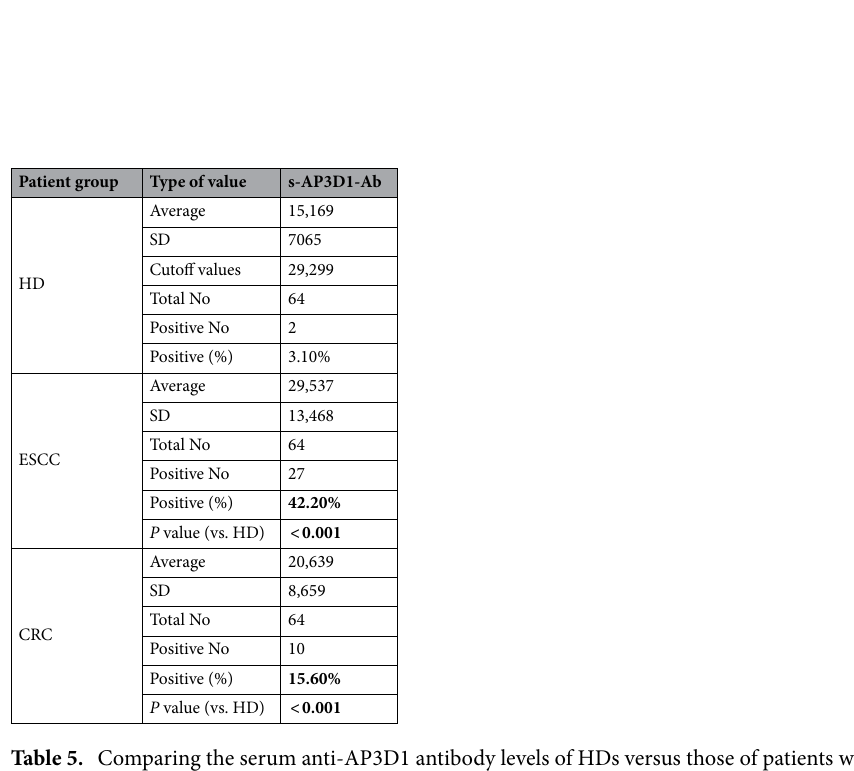
Table 5. Comparing the serum anti-AP3D1 antibody levels of HDs versus those of patients with esophageal squamous cell carcinoma (ESCC) and colorectal carcinoma (CRC). The s-AP3D1-Ab levels examined using AlphaLISA in HDs and patients with ESCC and CRC are shown. Purified AP3D1-GST proteins were used as antigens. The numbers shown are as described in Table 1. P -values of < 0.05 and positive rates of > 10% are marked in bold font. The plots for these data are shown in Fig.